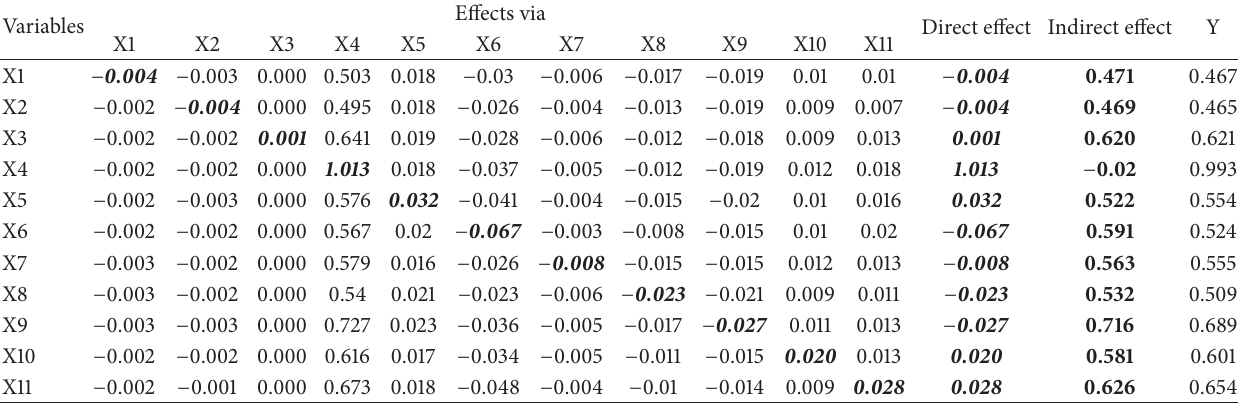
Table 4: Path coefficient (direct and indirect effects) of the measured variables attributed on grain yield variation of wheat in noninoculation condition and different water levels.